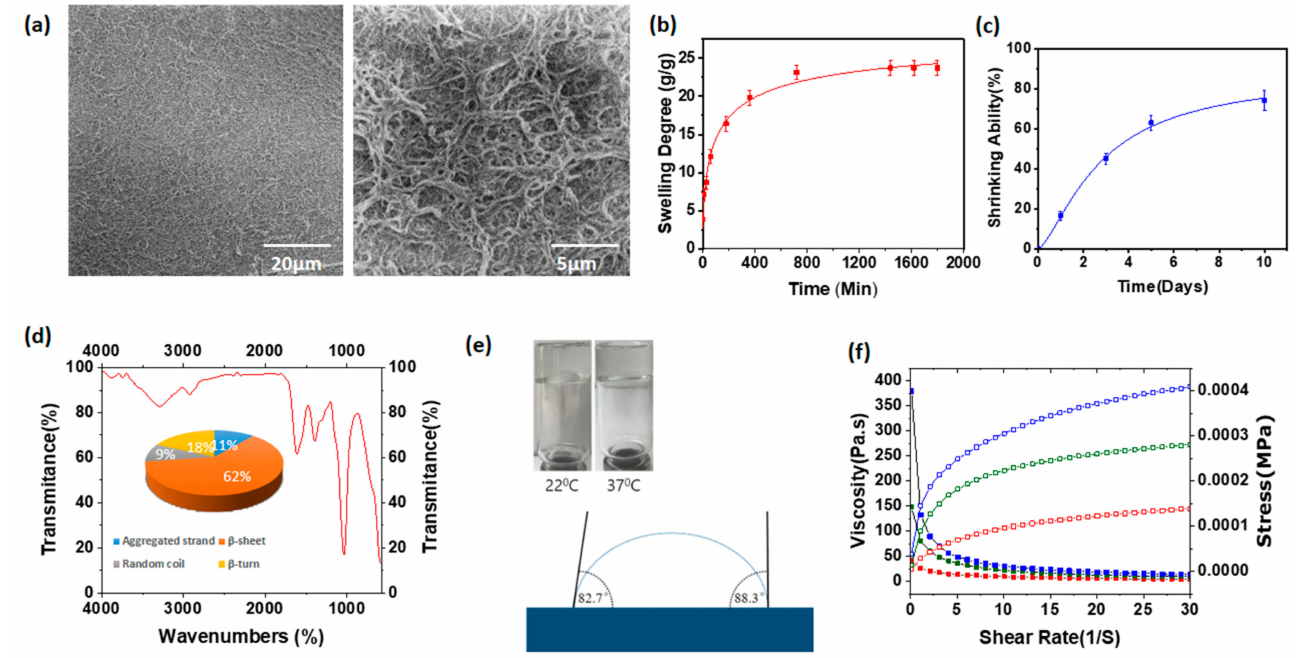
Figure 3. ( a ) Scanning electron microscopy images of hyaluronic acid/spider silk-based hydrogels under magnifications of 20 µ m and 5 µ m. ( b ) Swelling degree of hyaluronic acid/spider silk-based hydrogels. ( c ) Shrinking percentages of the hydrogels compared to initial weight over a 10 day period. ( d ) FTIR spectroscopic analysis and secondary structural analysis of hyaluronic acid/spider silk-based hydrogel. ( e ) Contact angle measurements of hyaluronic acid/spider silk-based hydrogel by KRUSS and flip test of hydrogels at 22 ◦ C and 37 ◦ C. ( f ) Viscosity and rheological properties of HA/Ss hydrogel at pH 7.2, 22 ◦ C; pH 7.2, 37 ◦ C; and pH 4.5, 22 ◦ C